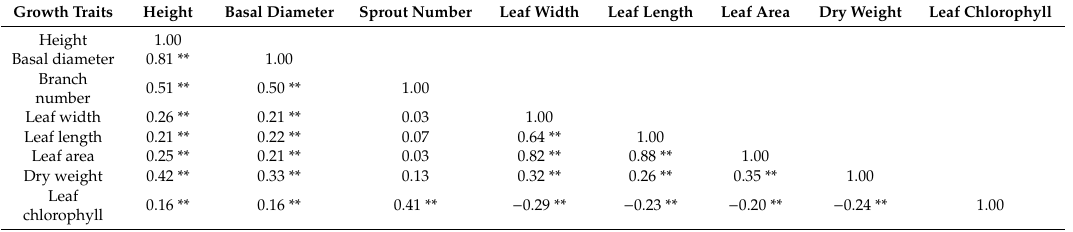
Table 5. Pearson correlation coefficients (r) among growth traits.